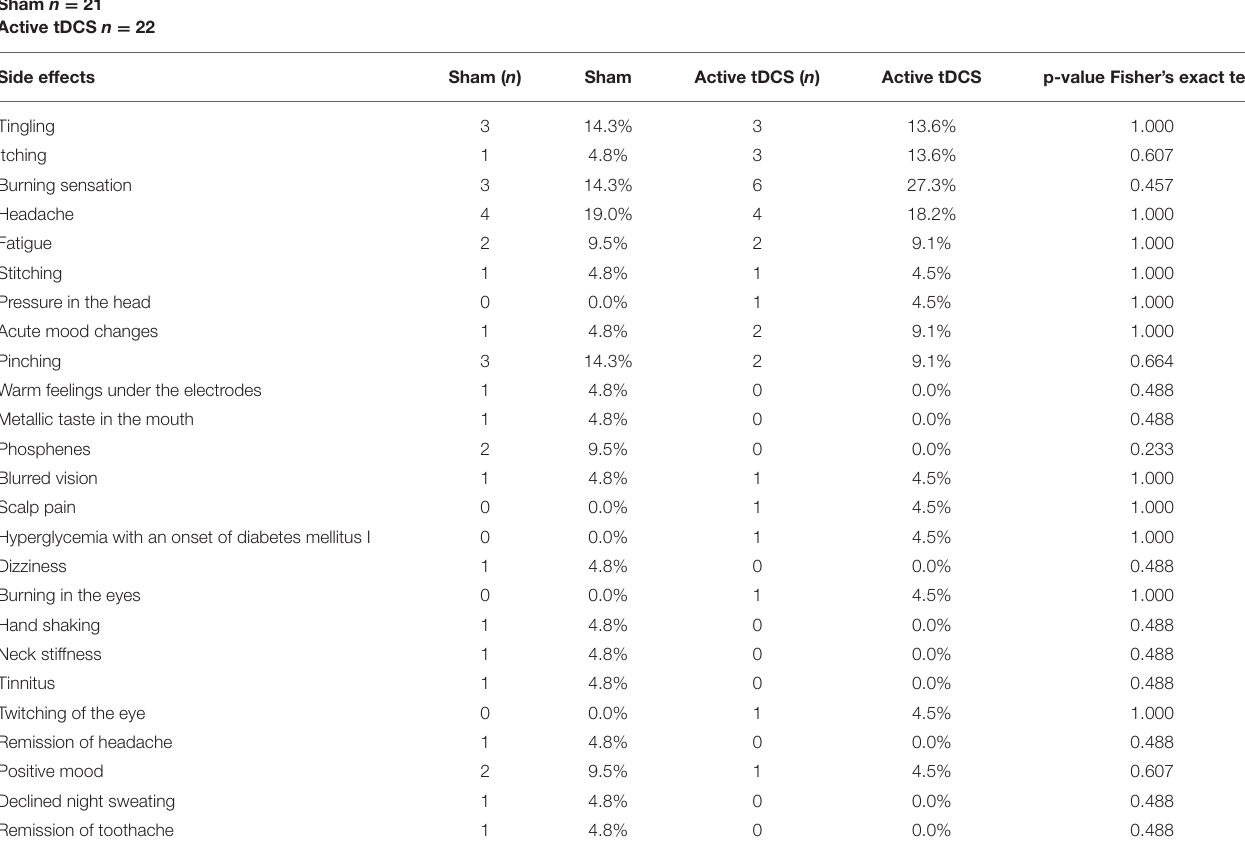
TABLE 6 | Summary of side effects. Total number of patients n =